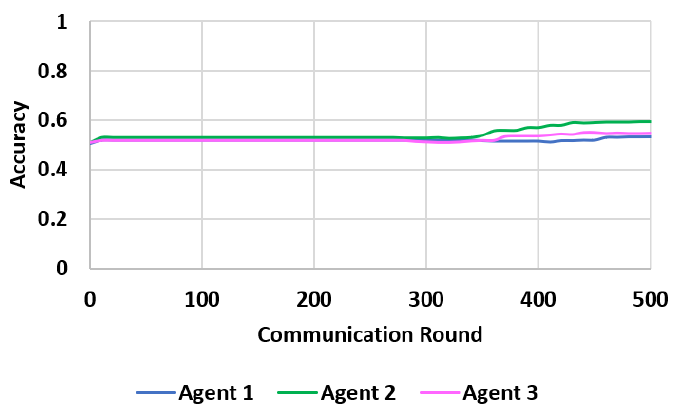
Figure 16. FedResilience’s impact on participating FL agents’ (three agents and two stragglers) model accuracy for the prediction of CIA outages.